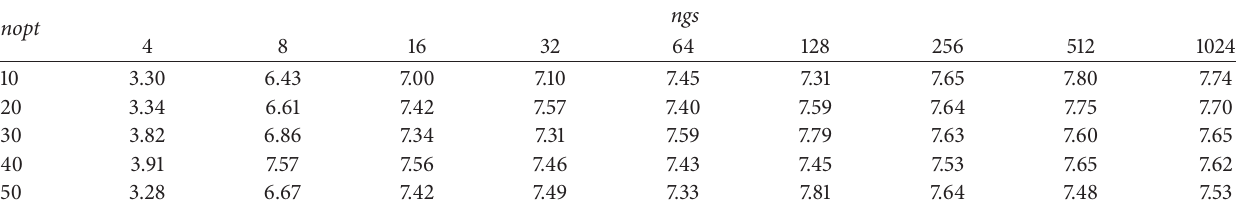
Table 4: Speed-up ratio of the OMP-SCE-UA versus the Serial-SCE-UA.